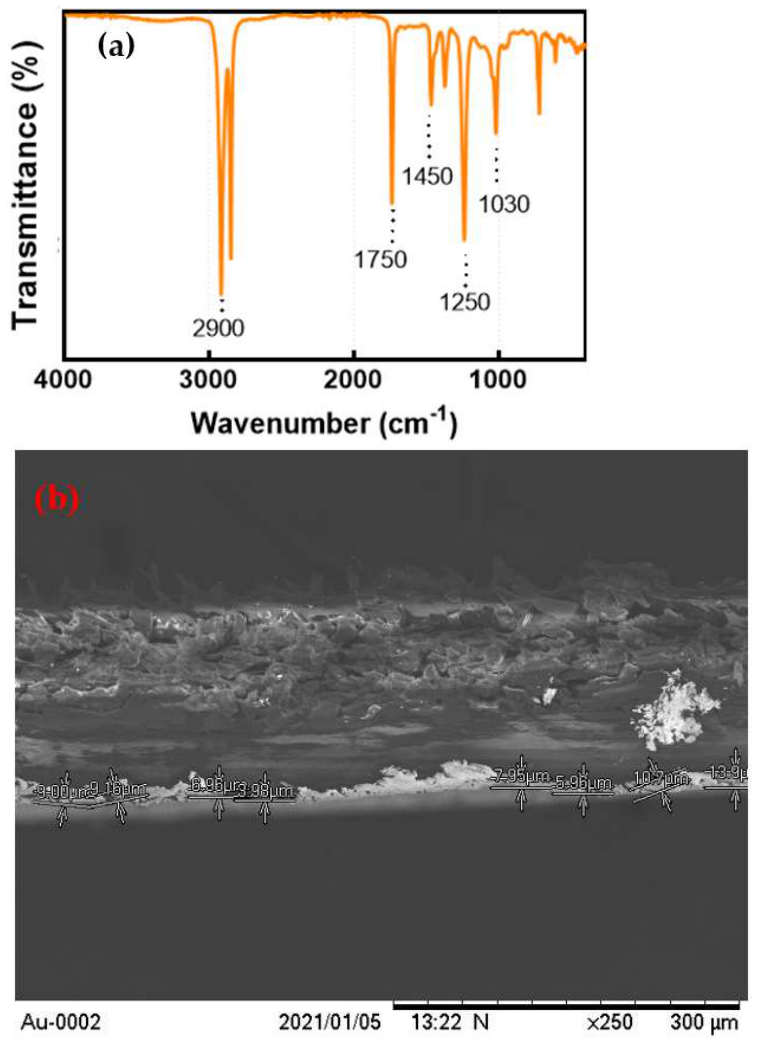
Figure 2. ( a ) FTIR spectrum and ( b ) SEM micrograph of the cross-section of Au leaf used for fabrication of microfluidic chip.